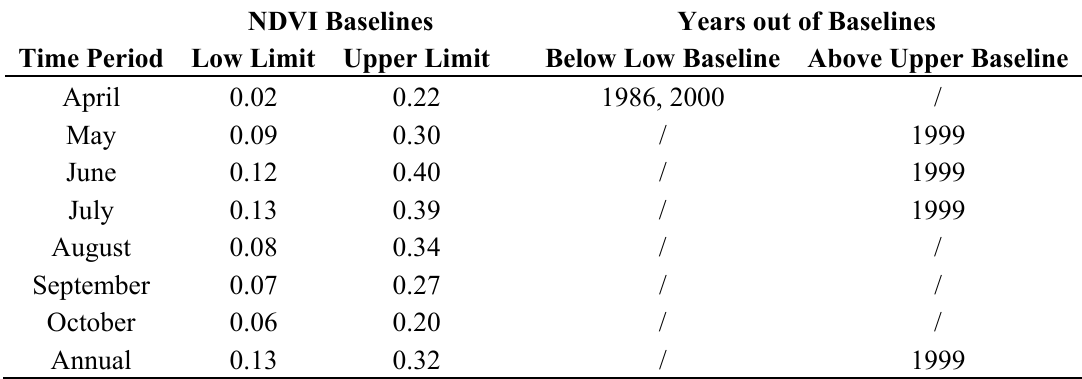
Table 4. The baselines of monthly and annual NDVI and years out of baselines from 1985 to 2007. NDVI